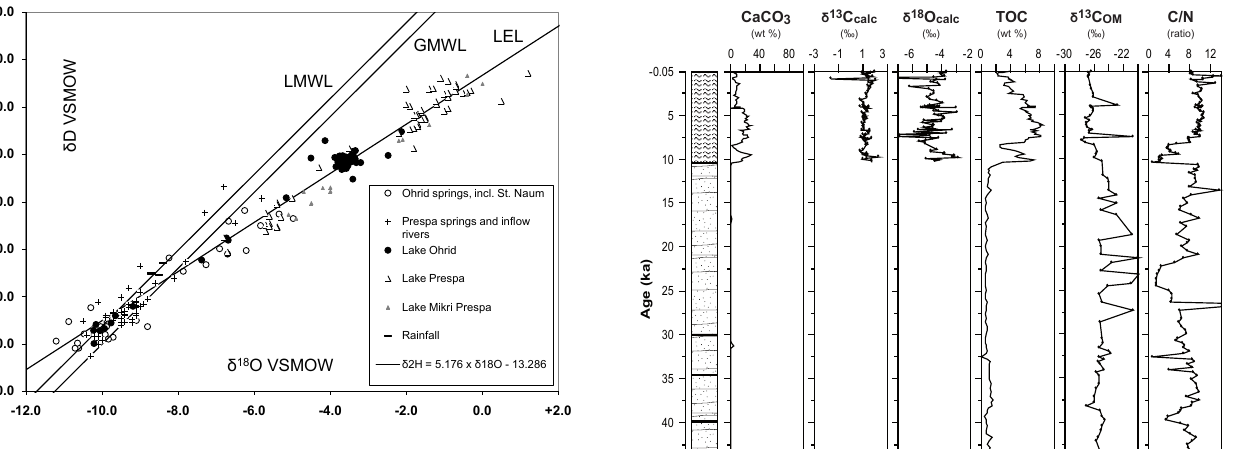
Fig. 2. The isotopic ( δ 18 O and δ D) composition of present day wa- ters from a variety of springs around Lakes Ohrid and Prespa (and Lake Mikri Prespa), as well as the lakes themselves. The Global Meteoric Water Line (GMWL) and the Local Meteoric Water Line (LMWL, Anovsky et al., 1991; and Eftimi and Zoto, 1997) are also given.